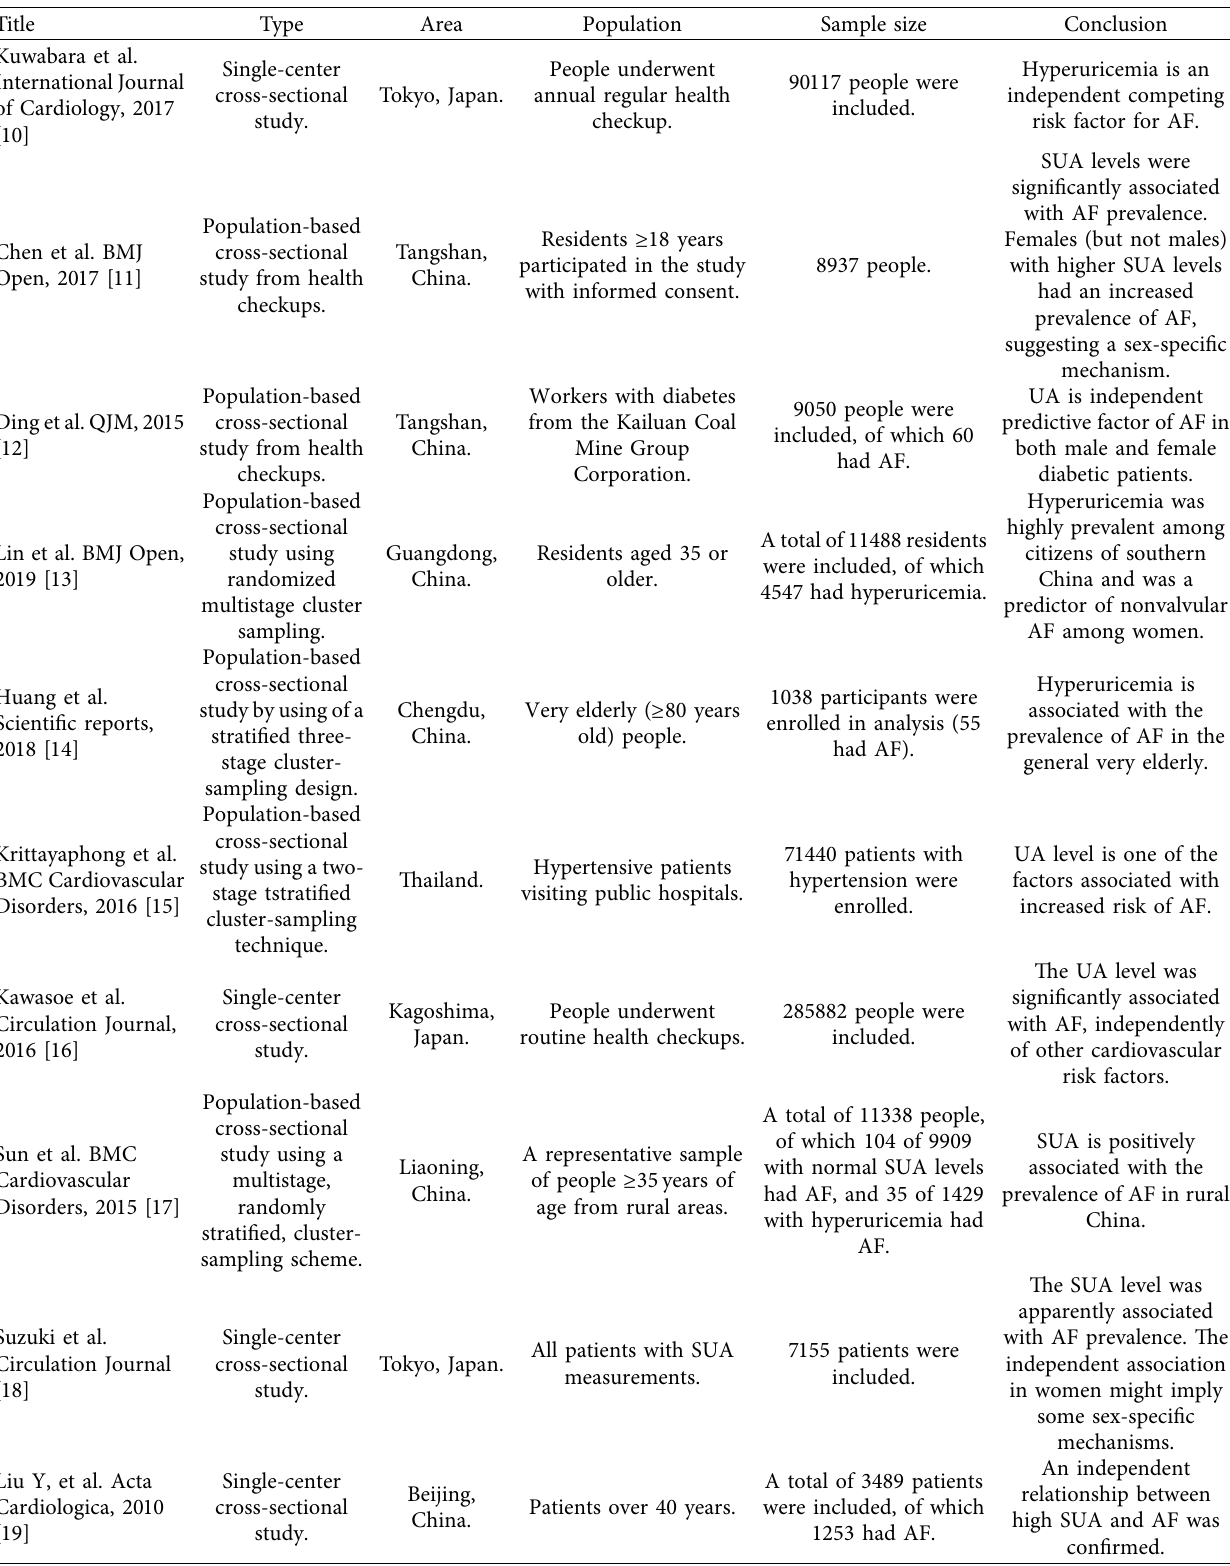
Table 1: Details of the